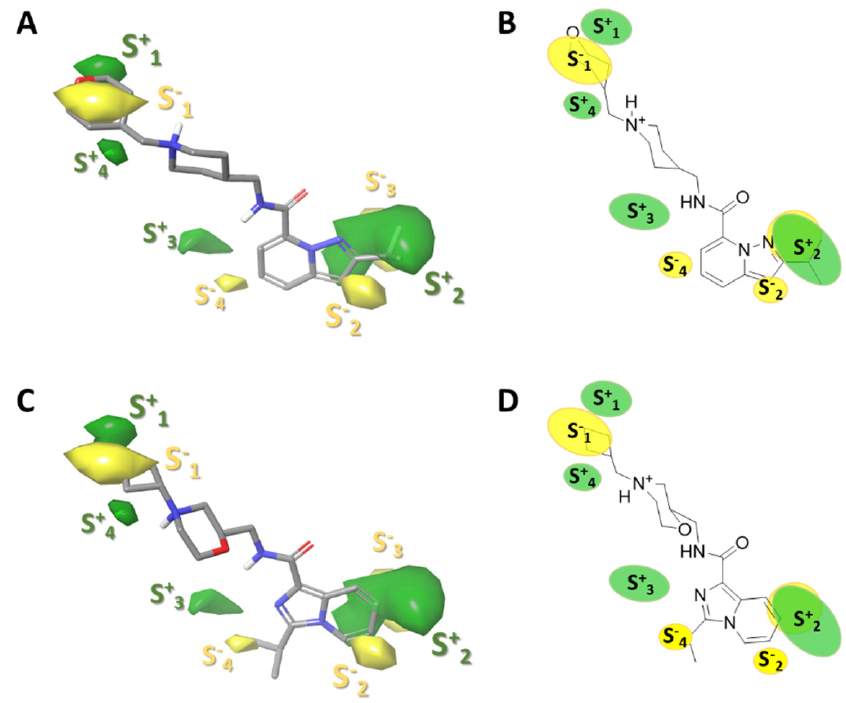
Figure 4. Contour maps obtained for the best Gaussian-based 3D-QSAR model steric (hydrogen bond donors, HD), green and yellow regions indicate a favorable and unfavorable steric interaction, respectively. An active molecule ( 53 ) is represented in ( A ) (sticks representation) and ( B ) (as draw representation). Less active molecule ( 5 ) is shown in ( C ) (sticks representation) and ( D ) (as draw representation).